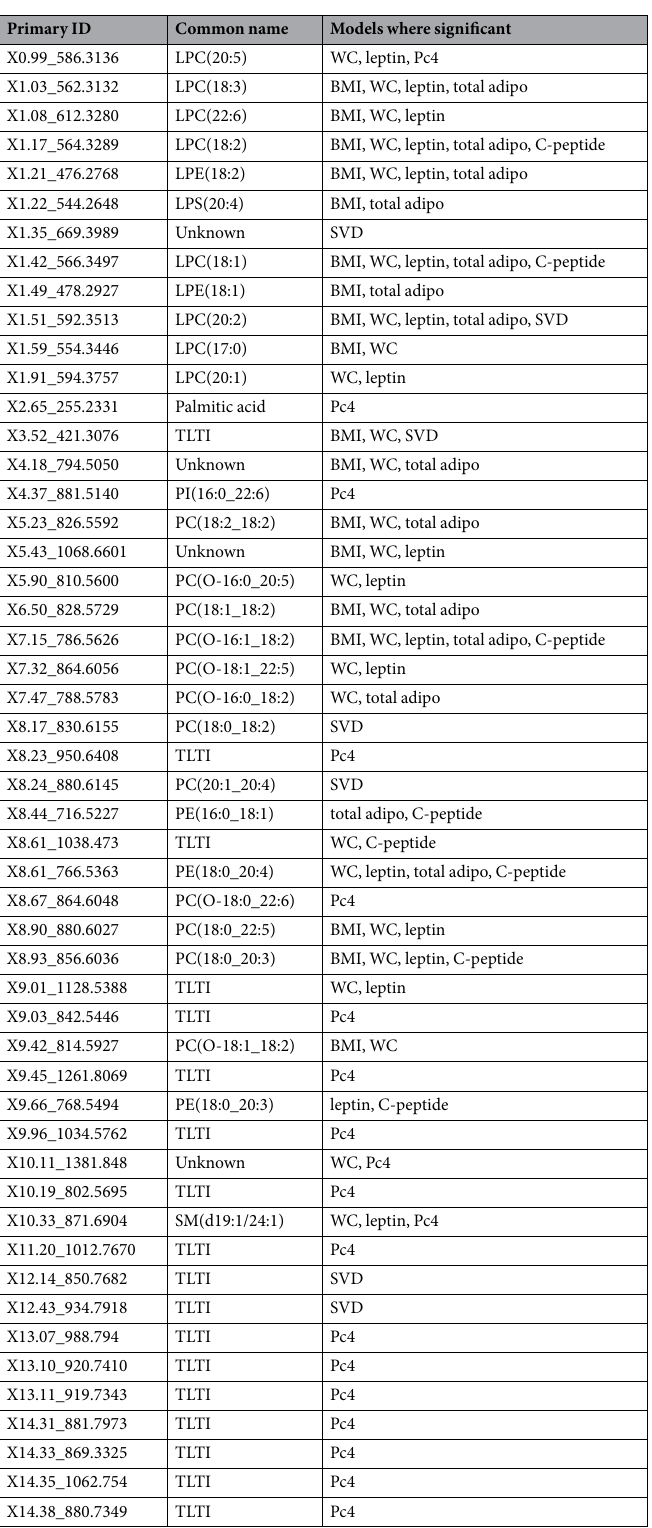
Table 3. Identification of plasma lipid biomarkers. The structural of identification of plasma lipids was performed based if m/z : was significant in two or more models from single marker regression analyses of responses, or had a radii ≥ 0.15 in singular value decomposition analysis, or was one of the top ten lipids positively and inversely associated with principal component 4. Plasma lipids meeting this criterion that were too low to identify (TLTI) are listed. Plasma lipid common names determined by lipid structure identification using Lipid Maps and Human Metabolome databases, and manual confirmation of mass spectra. The